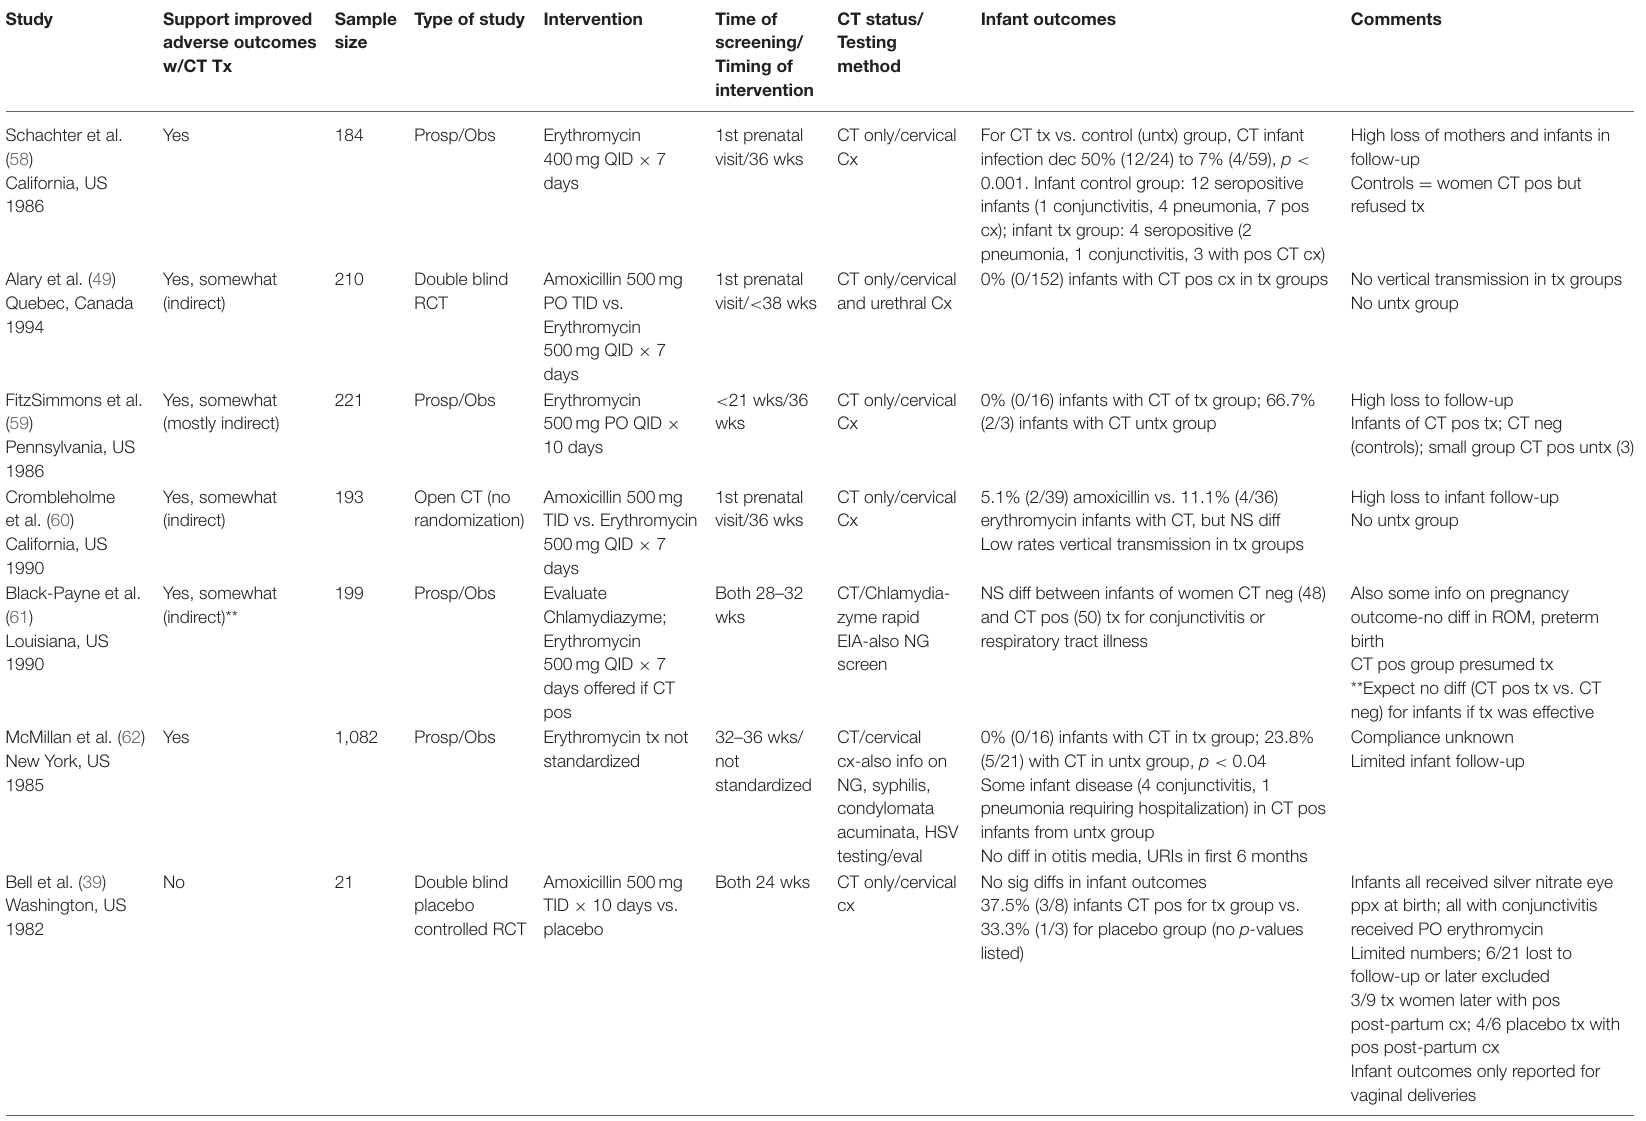
TABLE 3 | Prevention of adverse neonatal outcomes with antenatal chlamydial treatment (total studies N = 7).